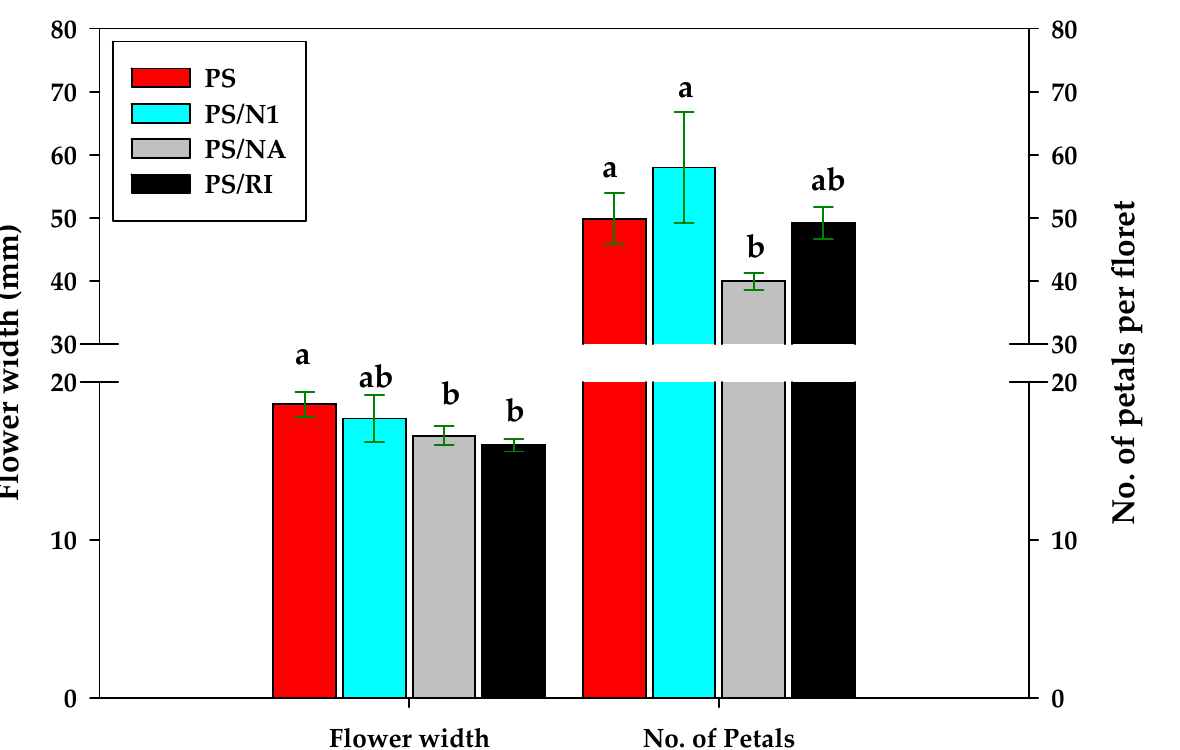
Z Values followed by different letters within a column are significantly different (Duncan’s multiple range test, p < 0.05. n = 15). PS: scion plant of spray rose Rosa hybrida cv. Pink Shine; N1: rootstock of